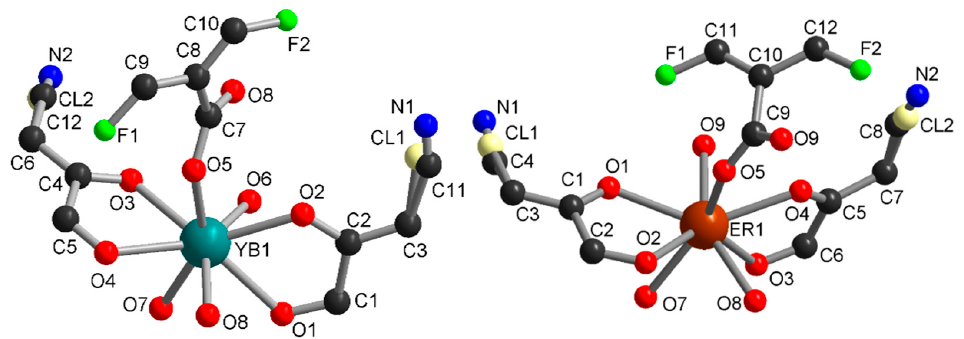
Figure 1. Asymmetric unit in 1 (left) and 2 (right).